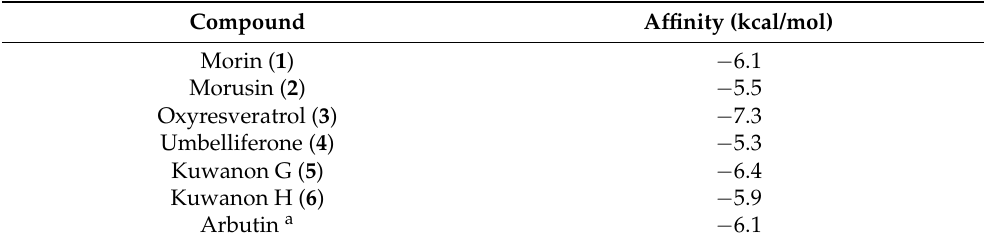
Table 10. Binding energies of bioactive compounds and arbutin calculated in